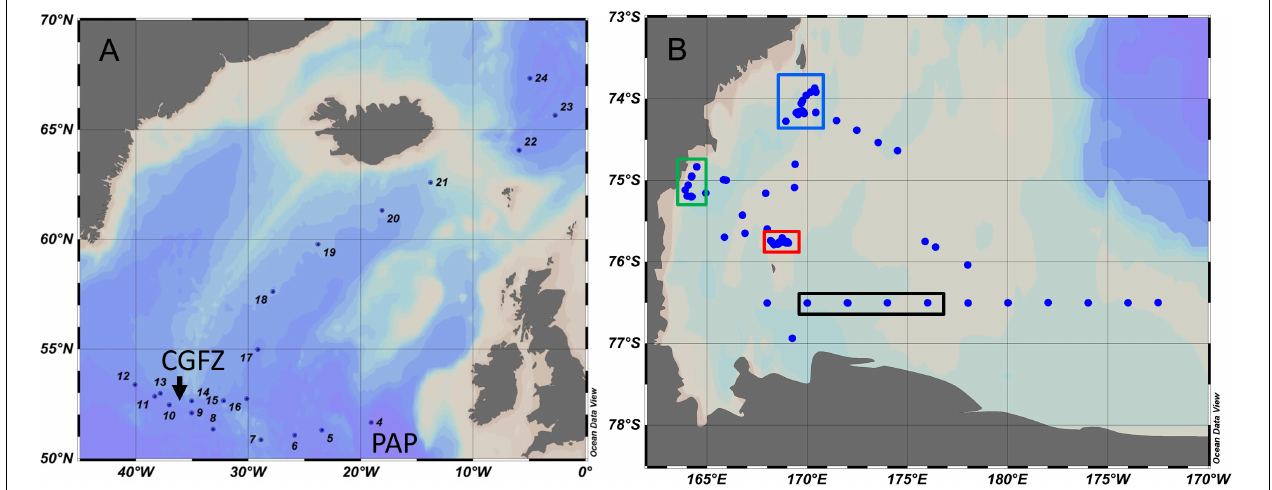
FIGURE 1 | Stations occupied in the North Atlantic (June–July 2012) (A) and the Ross Sea (February–March 2013) (B) . CGFZ, Charlie Gibbs Fracture Zone is a pair of deep-sea trenches characterized by a thriving benthic community due to high primary productivity and export of organic carbon to deeper layers. PAP, Porcupine Abyssal Plain. During the Ross Sea expedition NBP1302, we revisited three areas indicated by red, green, and blue rectangles. The black rectangle shows the four 76 ◦ 30 (cid:48) transect stations used in this